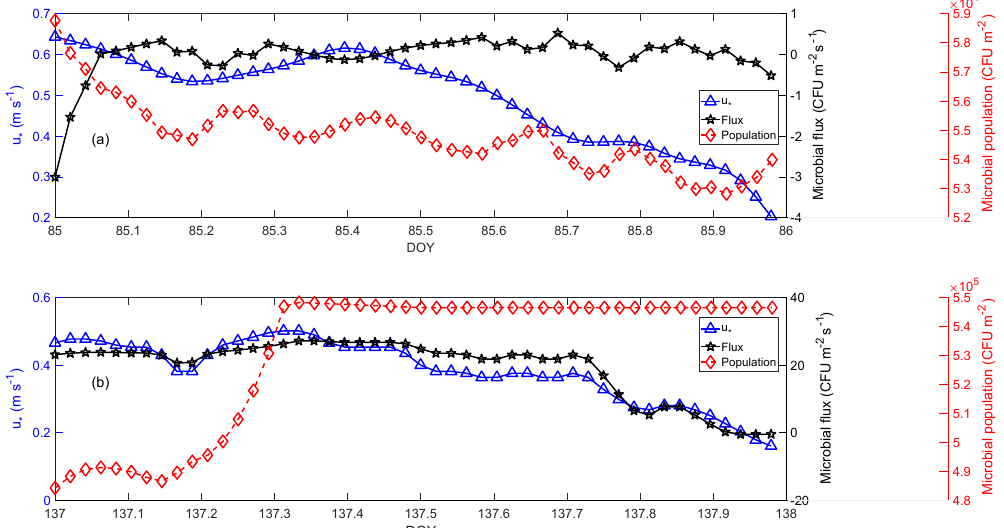
Figure 8. A high u ∗ / low flux event (a) and low u ∗ / high flux event (b) as simulated for the year 2015. The x axis indicates the fractional day of the year (DOY, Northern Hemisphere) for these two events, the left y axis shows the u ∗ values, the top far-right y axis shows the microbial net flux, and the bottom far-right y axis shows the phyllospheric population